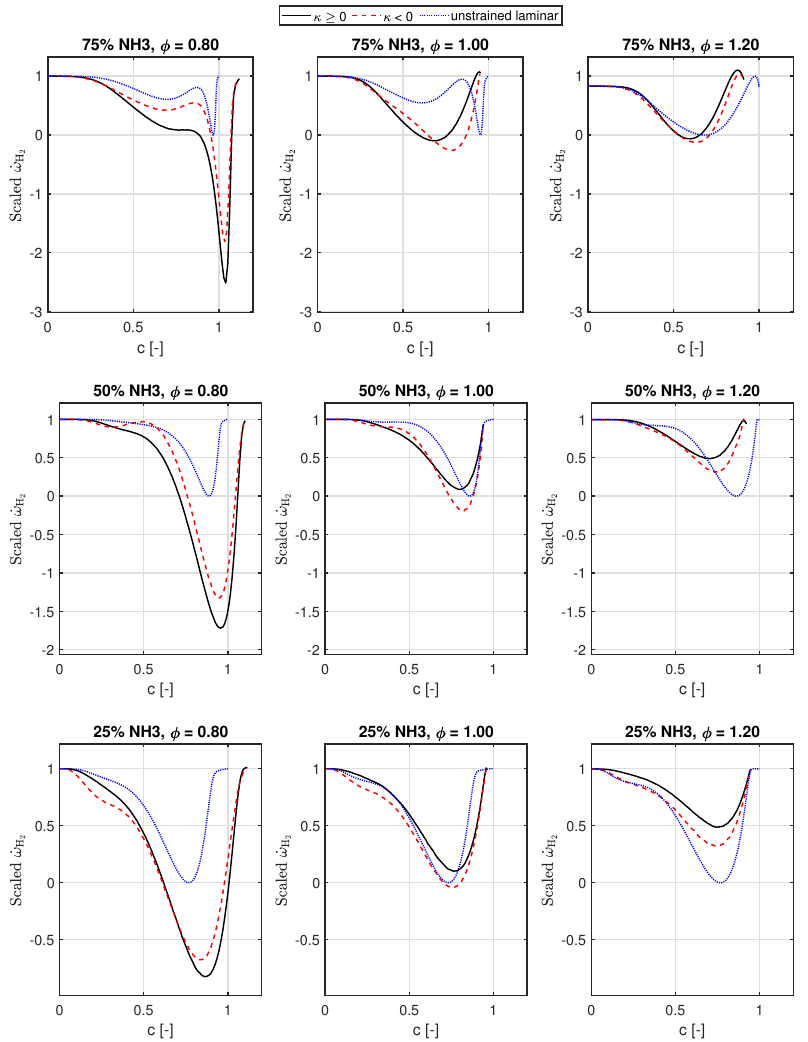
Figure 5. Conditional average of the source term of hydrogen split by positive and negative curvature. As the equivalence ratio increases to stoichiometric and beyond, for a negative cur- vature, the flame has a higher consumption of hydrogen compared to the lean case. To understand this phenomenon, in Figure 6, the reaction rates of the most important reactions involving hydrogen molecules have been plotted in a similar process as Figure 5. For globally lean cases, reactions involving H 2 as reactants will see enhancement of the positive curvature as the local equivalence ratio increases for these curvature values. However, as the global ratio is increased, these reactions are not further enhanced for positive curvatures as the local equivalence ratio gets higher, and the points on the flame front with negative curvature are now closer to the stoichiometric ratio. An H radical reacts with NH x to produce H 2 . This reaction is enhanced again for a positive flame curvature, since the production of an H radical is higher in these areas; however, this does not reduce the H 2 consumption since the reaction rates are approximately 3 to 5 times less than the consumption reaction: It is also of note that the difference in the rates for negative and positive curvatures is higher for the lean case, which can be related back to the fact that the flame surface for the rich case has lesser spread in the local equivalence